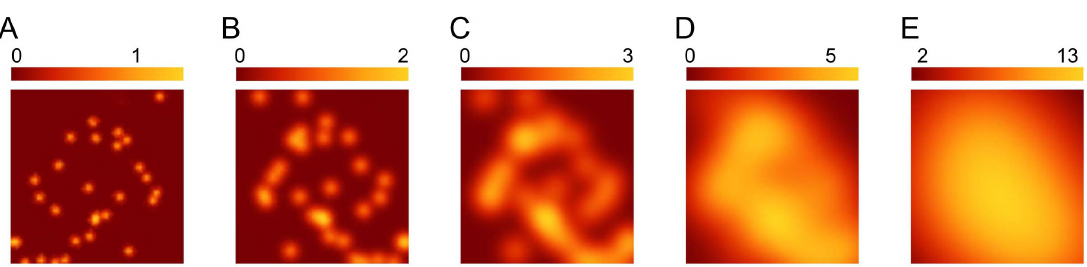
Figure 1. Averaging over cellular inputs by diffusion. Microbes use extracellular secretions for external digestion and other functions. The extracellular concentration of secretions at any location depends on the secretions of each cell in the population and the rate at which the secretions diffuse across space. When diffusion rates are low, then the concentration near a particular cell depends mainly on the secretion rate of that cell. When diffusion rates are high, then the concentration near a particular cell depends on the average secretion rate over all the cells in the common spatial neighborhood. (A) Concentration of an extracellular secretion in a low-diffusion environment. Each light-colored circle shows the location of a cell. The color index expresses the effective number of cells contributing to each spatial location. In this case, each cell is mainly affected by its own secretion rate. (B–E) Increasing diffusion rate causes a rise in the effective number of cells contributing to the extracellular concentration at each location. With high diffusion, the concentration depends on the average secretion rate over many different cells. If cells reduce their secretions in response to higher nearby extracellular concentration, then the total concentration may not change as the number of contributing cells per location increases. Instead, the same total may be achieved by a greater number of smaller inputs, in which case stochastic fluctuations in each input have less consequence for fluctuations in extracellular concentration. As the consequence declines for fluctuations of individual cells, one may expect weaker regulatory control per cell, and thus greater stochasticity per